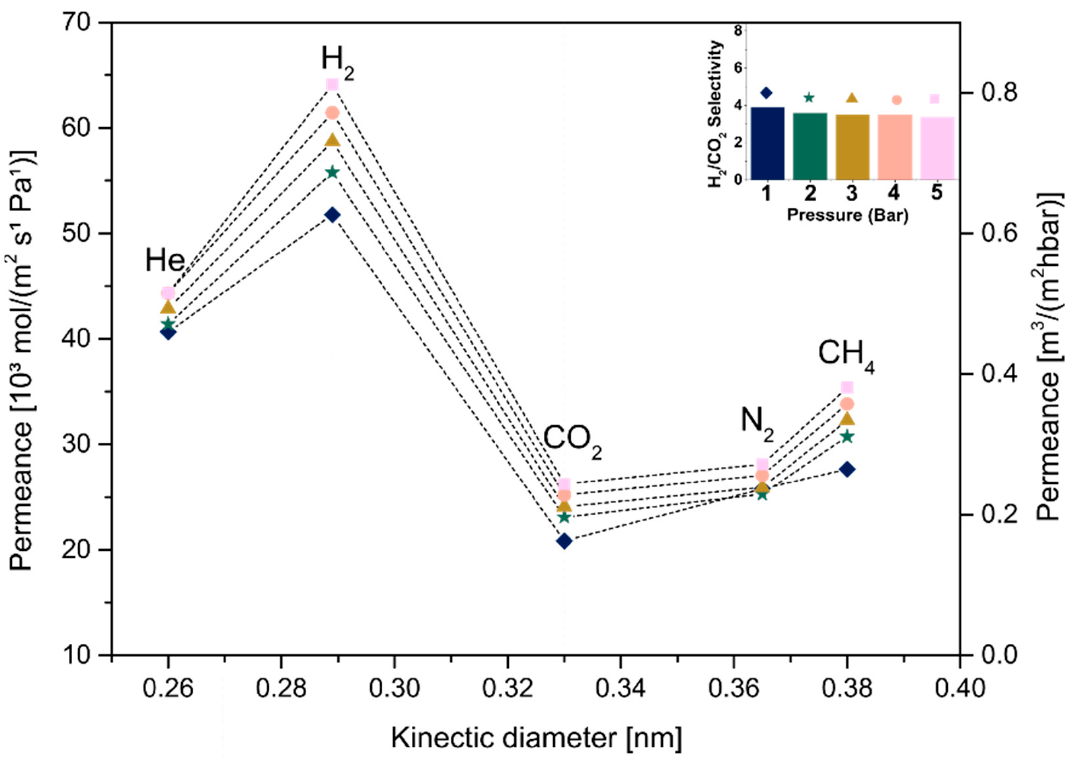
Figure 14. Single-gas permeabilities, permeances and H 2 /CO 2 selectivity under different pressures for C 2 _500.